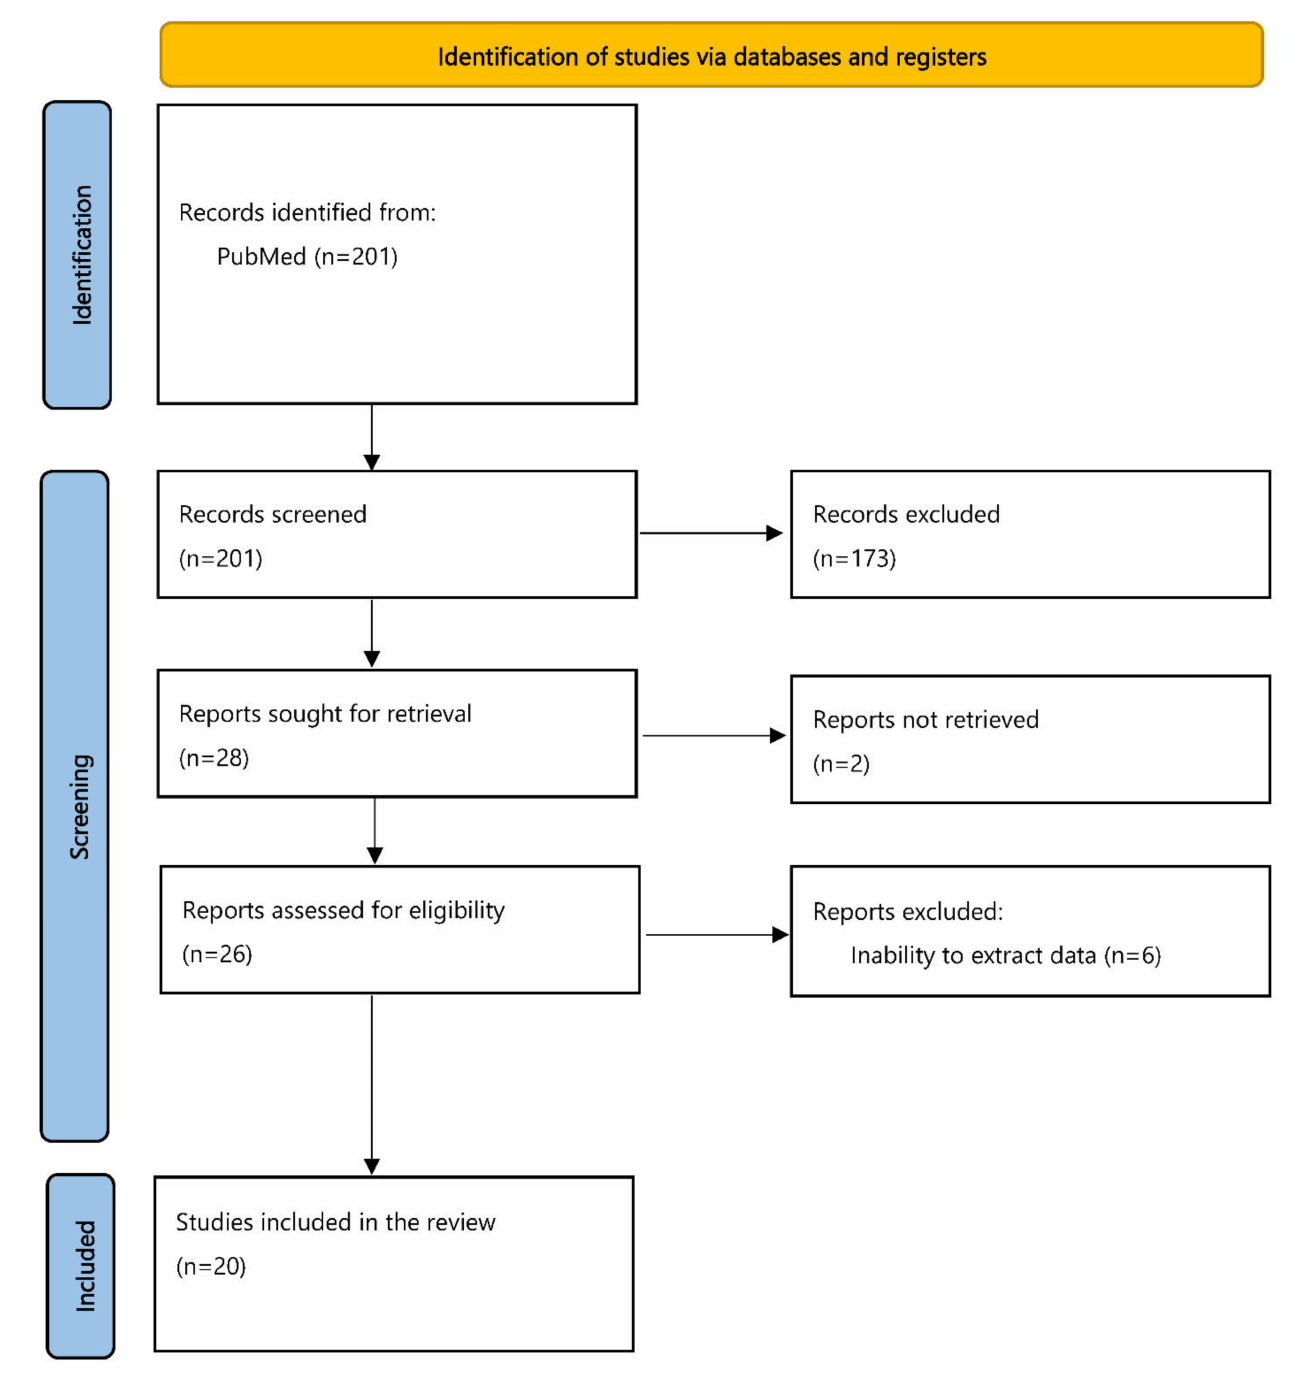
Figure 1. Flowchart of our